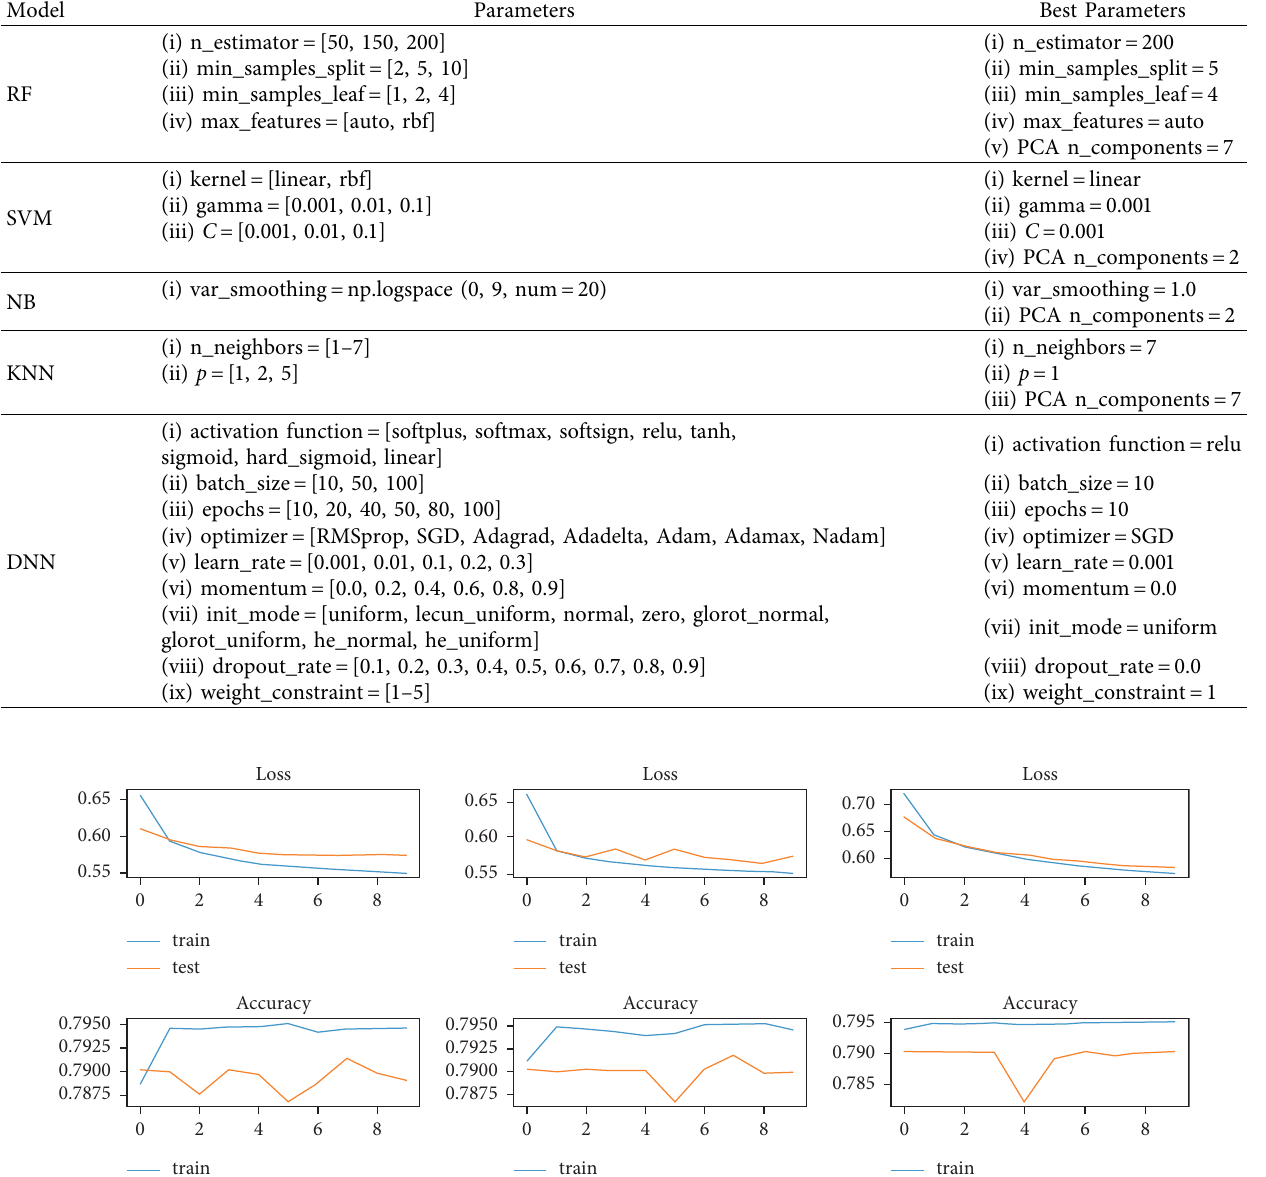
Table 2: Parameters considered for different machine and deep learning